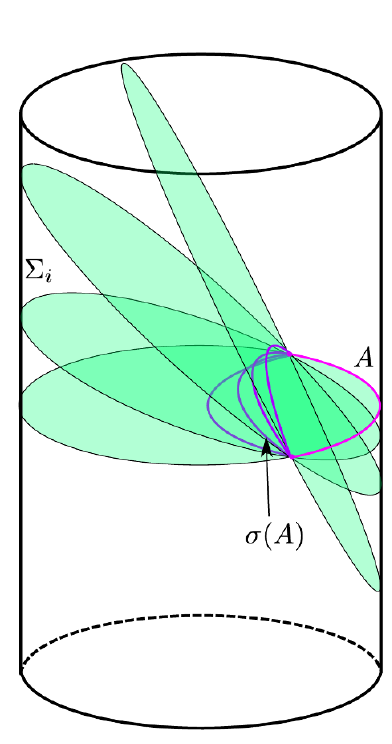
Figure 2 . For a (cid:12)xed boundary region A , we construct our holographic screens by (cid:12)rst (cid:12)xing a foliation (pictured here as green slices), such that each slice contains @A (where A is the pink section). Then, on each slice, we solve for the trapped surface (the purple curves). Each trapped surface is a leaf of a holographic screen, and stitched together, the collection of leaves comprises our holographic screen. In practice, we (cid:12)nd that solutions typically exist. The (cid:12)gure is based on numerical results in